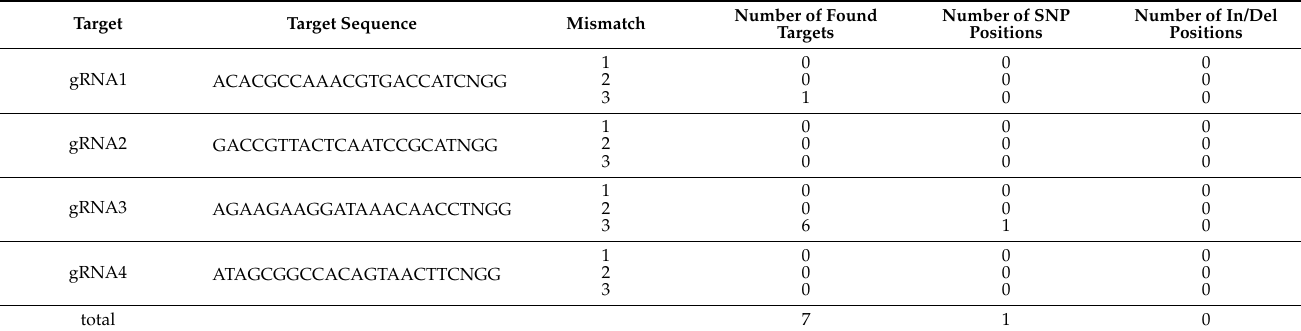
Table 3. Effect of chromatin structure on Cas9 activity at off-target sites of the ‘transgene-free’ GE2 mutant plants. Target